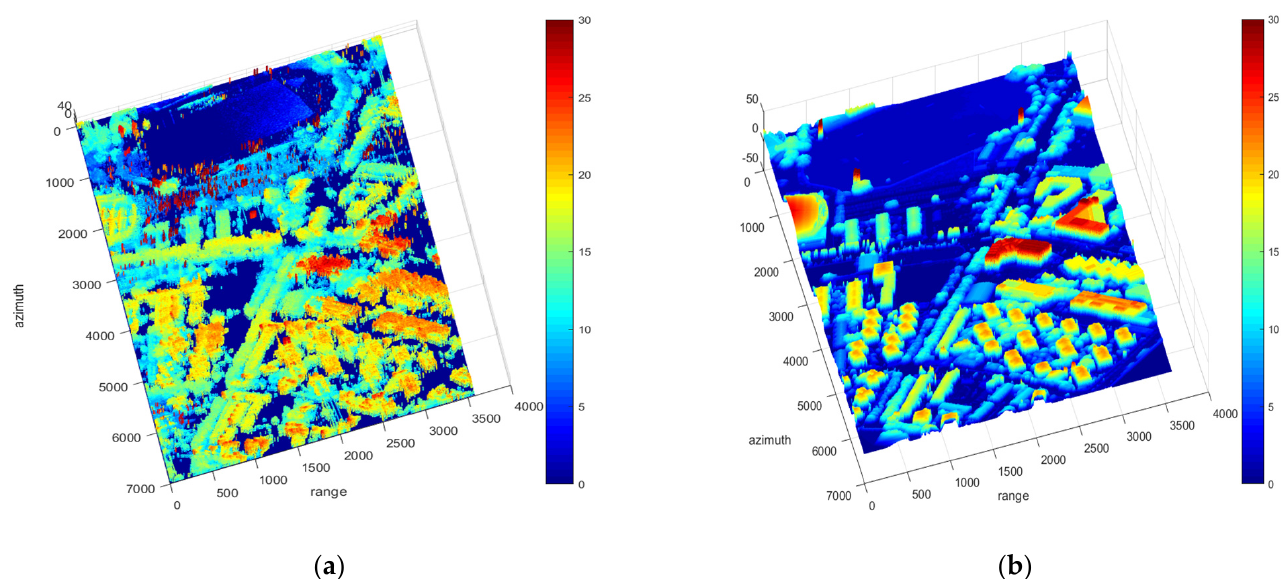
Figure 9. ( a ) Height retrived by polarimetric interferometry optimal decomposition in Shanghai (meters). ( b ) Real height obtained by optical oblique photography (meters).